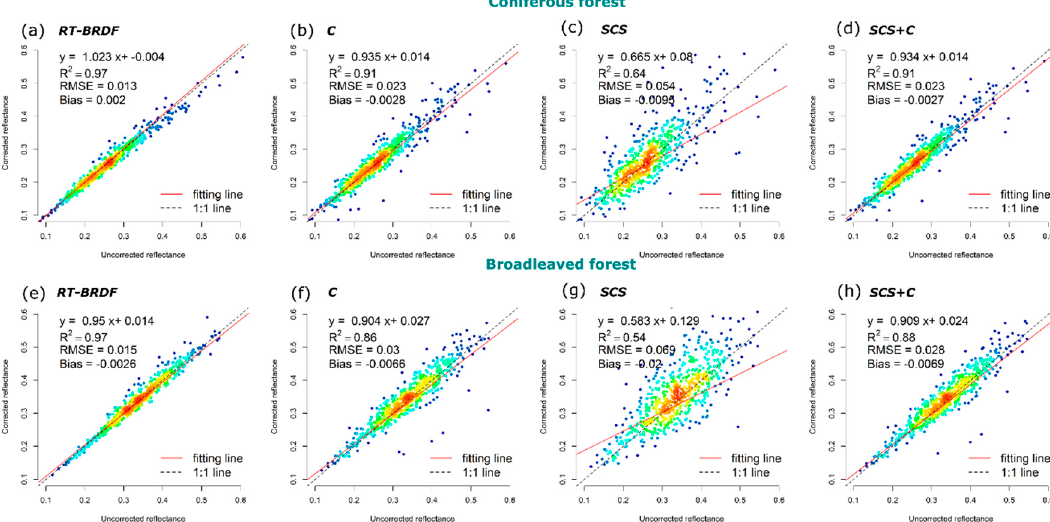
Figure 9. Density scatterplots of the relationship between corrected and uncorrected BOA apparent reflectance at 837.19 nm for aspect perpendicular to the solar direction for coniferous ( a – d ) and broadleaved ( e – h ) forest. The best linear fit is in solid red, and the 1:1 line is in dashed